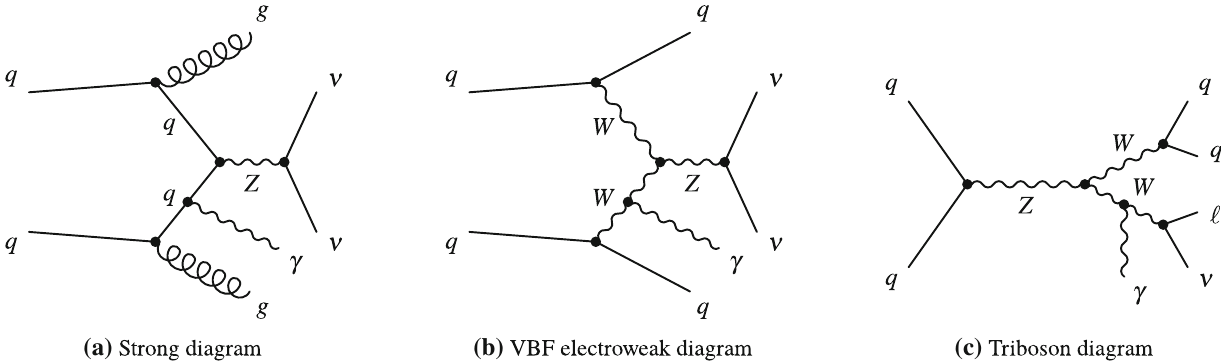
Fig. 1 Representative Feynman diagrams for the dominant SM processes contributing to the considered signature: a is an example of the order α 2 α 3 diagrams referred to as “strong”; b , c are examples of the order α 5 diagrams, which are collectively referred to as “electroweak” s